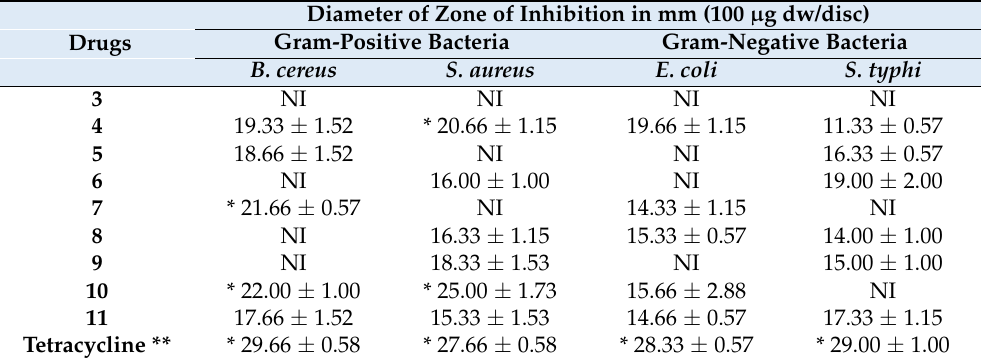
Table 3. The inhibition against Gram-positive and Gram-negative bacteria by the stearoyl rhamnopy- ranoside